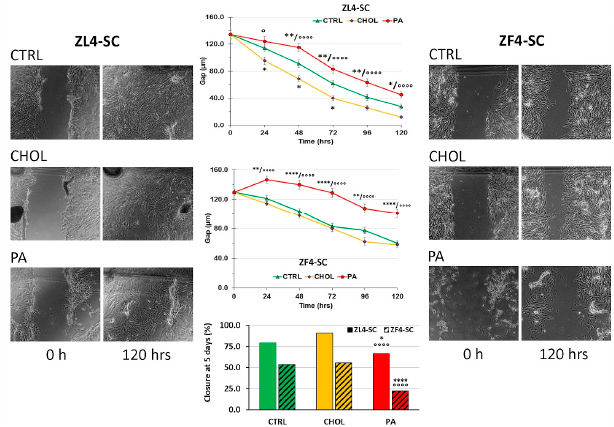
Figure 5. The ZL4-SC were considerably more effective than ZF4-SC on a scratch gap closure healing, and cholesterol improved it, whereas Na palmitate severely impaired it. ZL4-SC and ZF4-SC were incubated separately, as depicted in Figures 1 and 2 but in six-well plates as semi-confluent cultures. The cells were incubated with cholesterol, Na palmitate, or no addition for 4 days. Then a scratch wound was made, and the medium was changed to normal. The progression of the gap closure was monitored and documented for 5 days. Representative micrographs (100×) of ZL4-SC at initiation and completion are shown at the left, and the ones for ZF4-SC at the right. In the middle, the time progression of the healing is shown at the top. * p < 0.01 (CHOL vs. CTRL); ** p < 0.01 ; **** p < 0.0001 (PA vs. CTRL); ° p < 0.05, °°°° p < 0.0001 (PA vs. CHOL). The bar graph shows the final, 120 h state. All symbols have uniform meaning. Myostatin overexpression, detected by Western blot, is the feature that characterized the long- term in vivo exposure of MDSC male cells to the T2D/O milieu [5,6] and the in vitro exposure to dyslipidemic serum of both MDSC and the female ZF4-SC [7,8]. It was also investigated here for the lipid factors acting only on ZF4-SC, and not ZL4-SC. The ZF4-SC selection was made to simplify the approach, since they are isolated from the T2D/O rat model, and continued for all successive assays. Int. J. Mol. Sci. 2020 , 21 , x FOR PEER REVIEW Beta-actin was used as a housekeeping gene. Figure 6, left panel, shows that cholesterol did stimulate the expression of the main 50 kDa band (and the ancillary 32 and 25 kDa bands), but much less than what we had reported for serum [7], and palmitate did not. The right panel shows that none of both factors stimulated the expression of the proliferation factor PCNA.